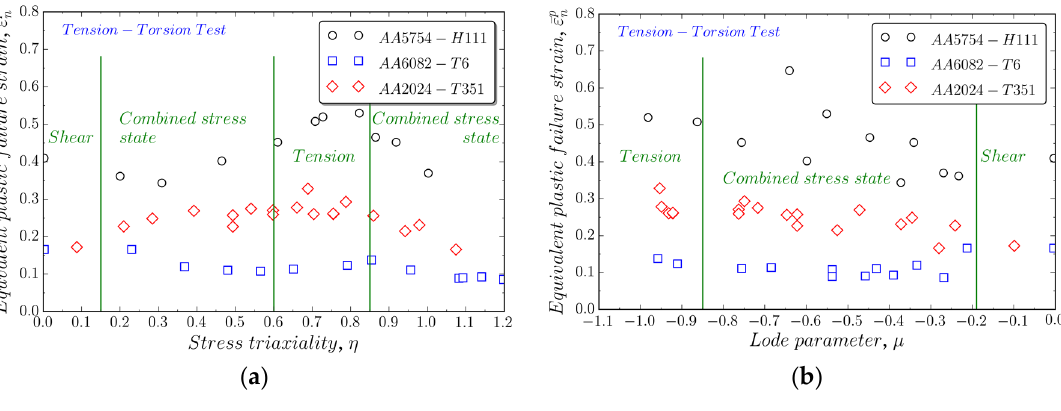
Figure 6. Failure locus on the space of equivalent plastic strain versus: ( a ) stress triaxiality; ( b ) Lode parameter.